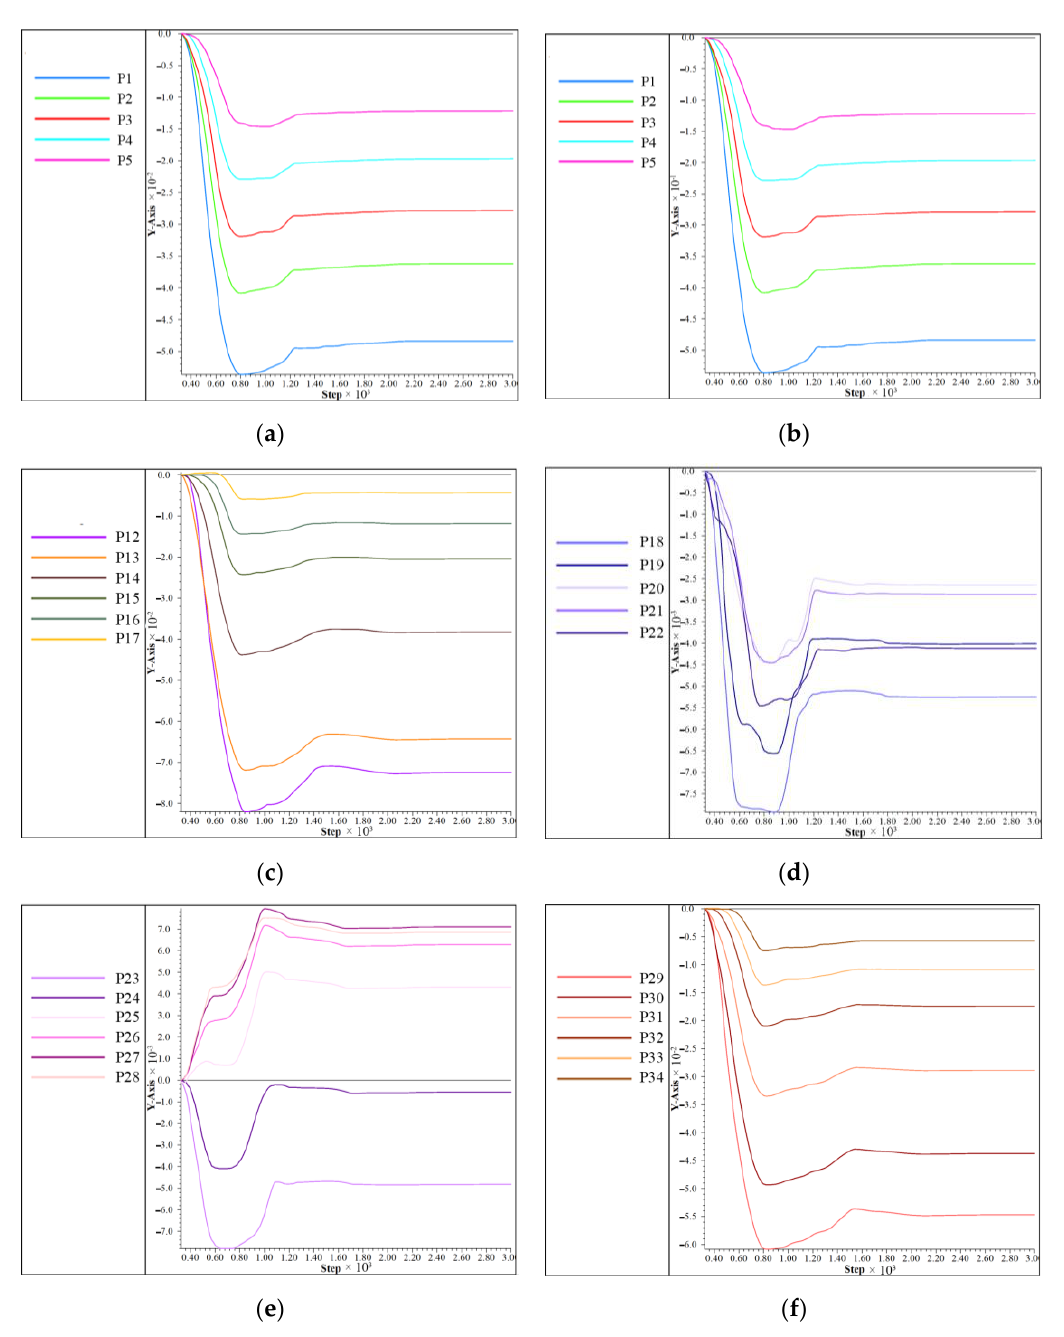
Figure 12. The results of each side slope displacement monitoring graphs: ( a ) slope A; ( b ) slope B; ( c ) slope C; ( d ) slope D; ( e ) slope E; ( f ) slope F.